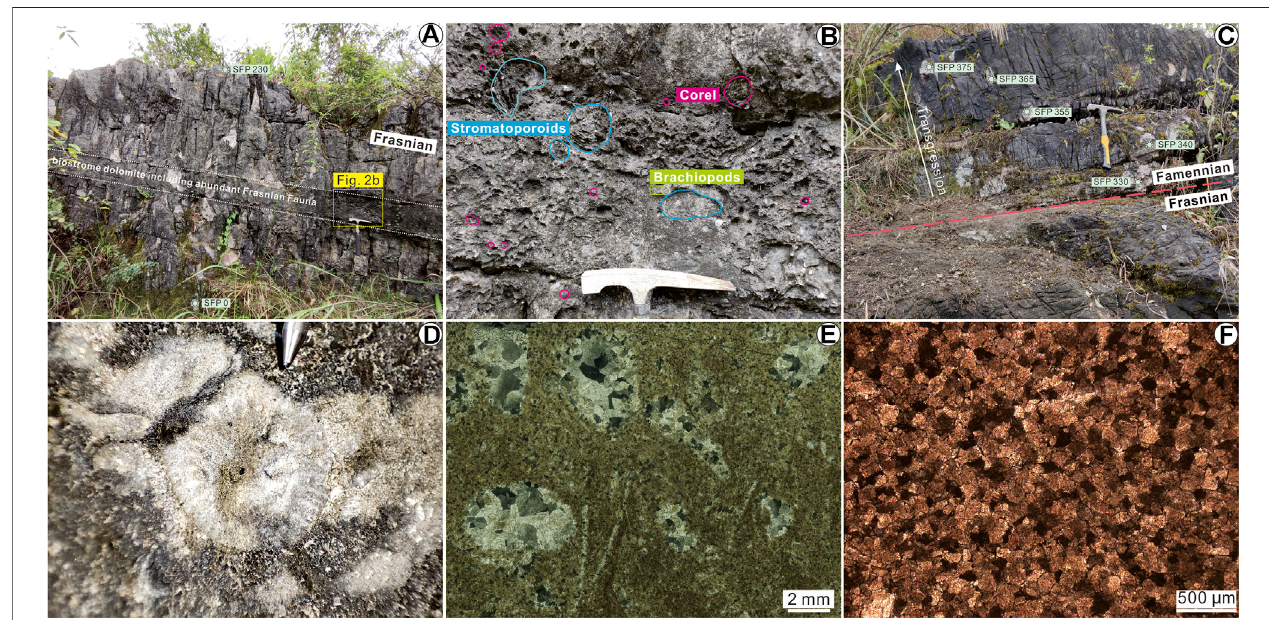
FIGURE 2 | (A) Field photo of Sifangpo section, Dushan area, showing biostrome dolomite. (B) Detailed view of biostrome dolomite at 2.4 – 2.6 m below the F – F boundary, showing abundant body fossils including stromatoporoids, coral, and brachiopods. (C) F – F boundary (dashed line) in the dolostone sequence, emphasizing thetransgression thatoccurredduringtheearliestFamennian. (D) Close viewofcoralinlatestFrasnianstrata. (E) Thin-sectionphotoofsampleSFP85,emphasizingthe abundance of dolomitic body fossils. (F) Thin-section photo of sample SFP320, emphasizing dolomite is the dominant rock-forming mineral.